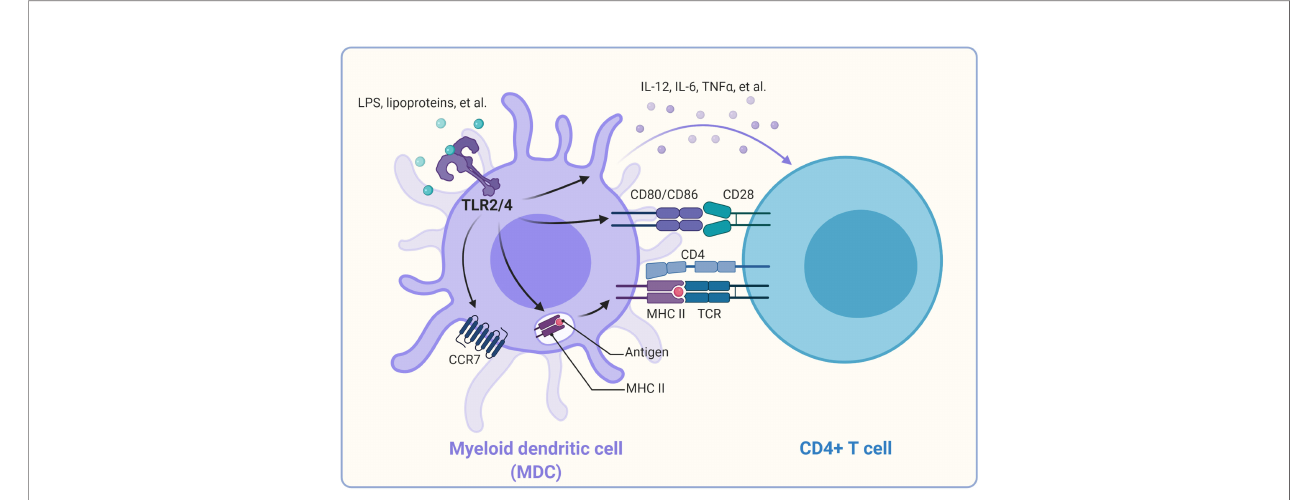
FIGURE 2 | Promotion of CD4 + T cell activation by TLRs on dendritic cells. Once TLR2/4 recognize their individual ligands, they can alter the expression of chemokine receptors (CCR2, CCR5, and CCR7), leading to DC migration from the infected tissue to the draining lymph node, where naïve T cells are stimulated. TLR2/4 signaling can promote the antigen process and bind to the major histocompatibility complex II and be presented to the CD4 + T cells, thus providing the fi rst signal for activation of the CD4 + T cells. In addition, TLR signaling triggers the up-regulation of costimulatory molecules on the cell surface of DCs, which provide the second signal to activate the antigen-speci fi c CD4 + T cells. TLR signaling can also induce the production of cytokines such as IL-12, TNF- a in DCs. These cytokines function as “ instructive ” cytokines and drive the activation and differentiation of CD4 + T